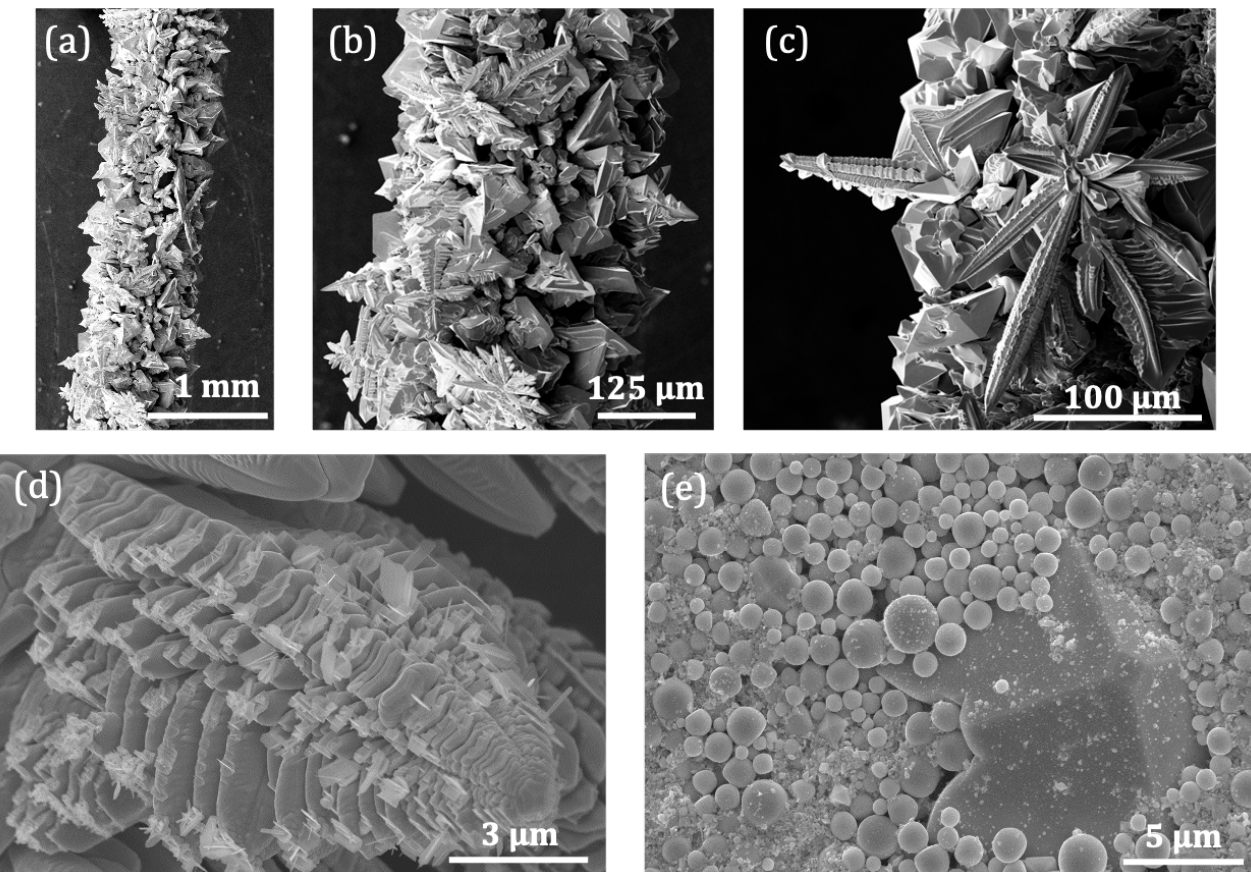
Figure 2. Secondary electron (SE) images of ( a ) WO ( c ) Zoom of the ( a ) SE image. ( d ) Detail of the micro- and nanostructures formed on the W wire. ( e ) SE image of nanostructures deposited on external copper electrodes located 3 mm apart from the